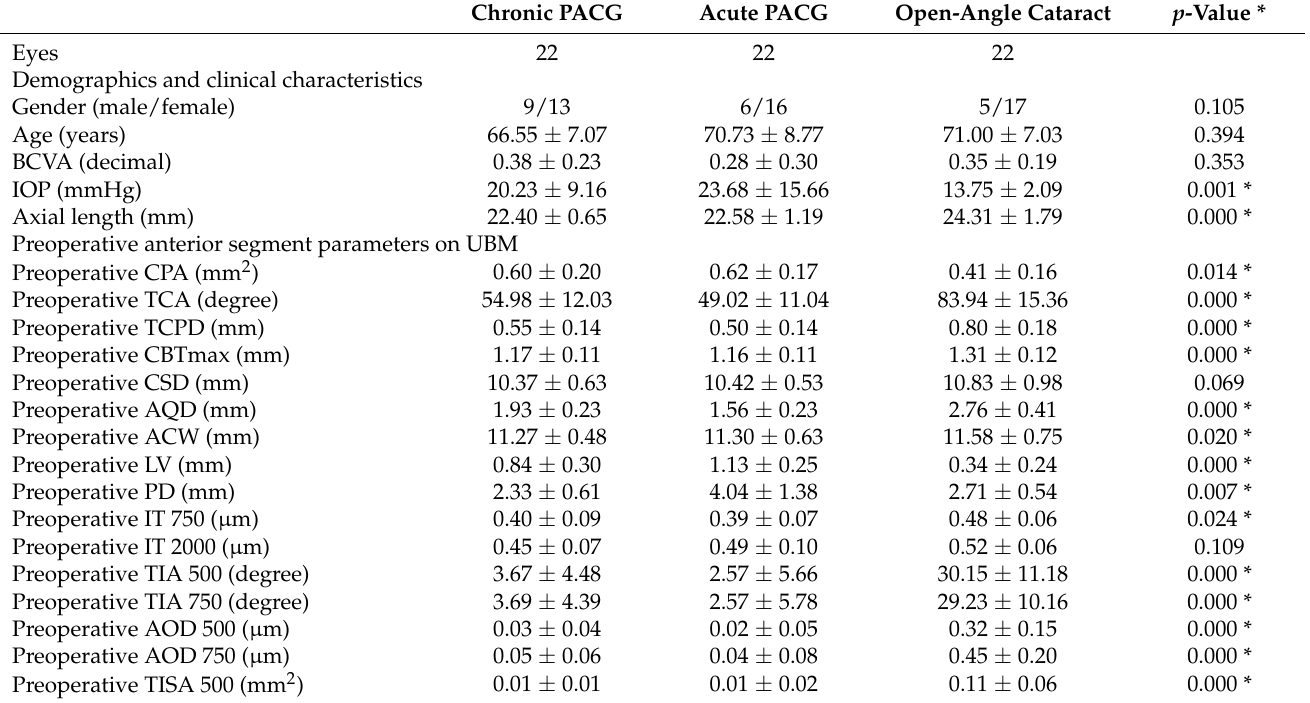
Table 1. Comparison of demographics, clinical characteristics, and preoperative anterior segment UBM parameters among the three